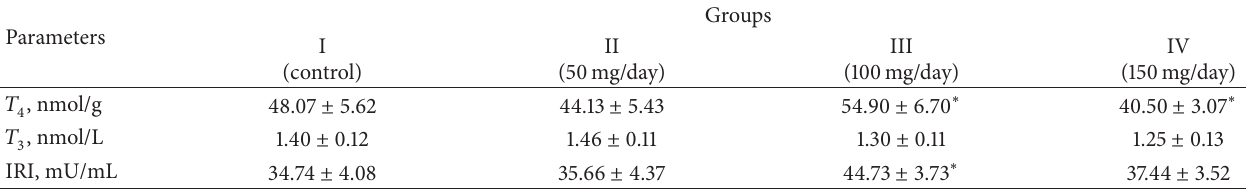
Table 3: Major parameters of the minks hormones taken from the control (I) and experimental (II–IV) animal groups (received phenozan).